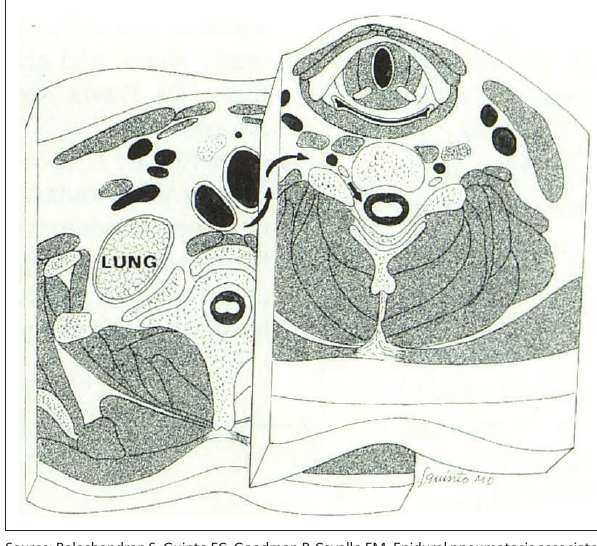
FIGURE 5: Diagram of the lower cervical and upper thoracic cross sections illustrating the pathway of air dissection (arrows) leading to epidural